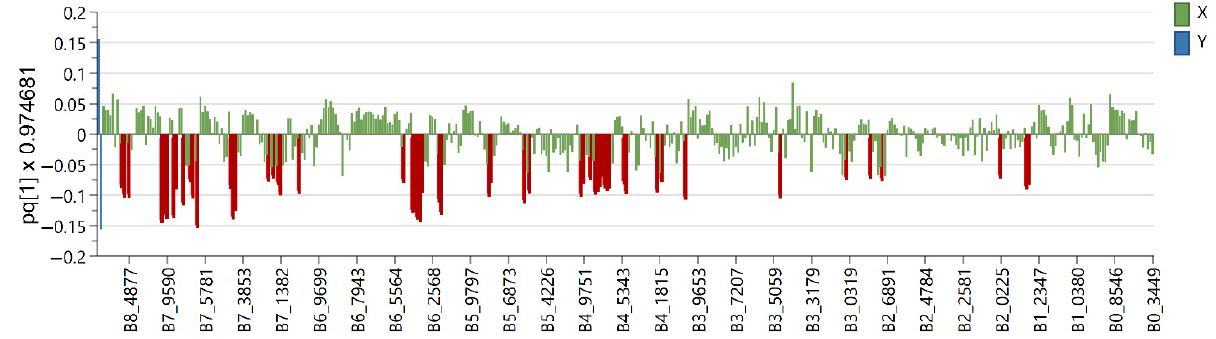
Figure 4. Loading plot with red and brown marked variables characteristic for E. seguieriana (Y variables—loading vectors scaled to unit length) in comparison to other species (X variables—chemical shift), obtained from the OPLS-DA model.